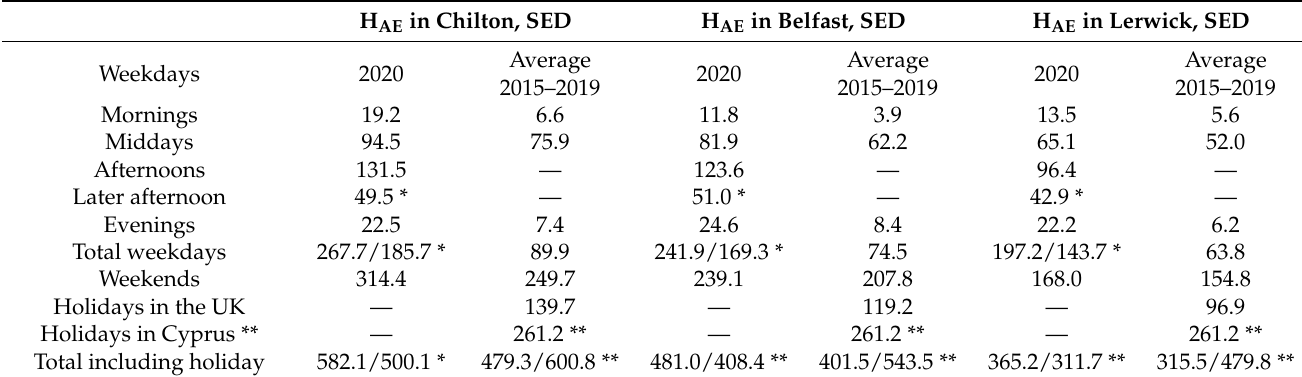
Table 3. H AE (in SED units) in unshaded outdoors based on April–June 2020 and the 2015–2019 average data for different exposure scenarios in Chilton, Belfast, and Lerwick. Note that H AE relates to the values measured on a horizontal plane and the human body may receive around 30% of these values on an assumption of randomly changing orientations. * Later afternoon exposure; ** total available erythema dose including a holiday in